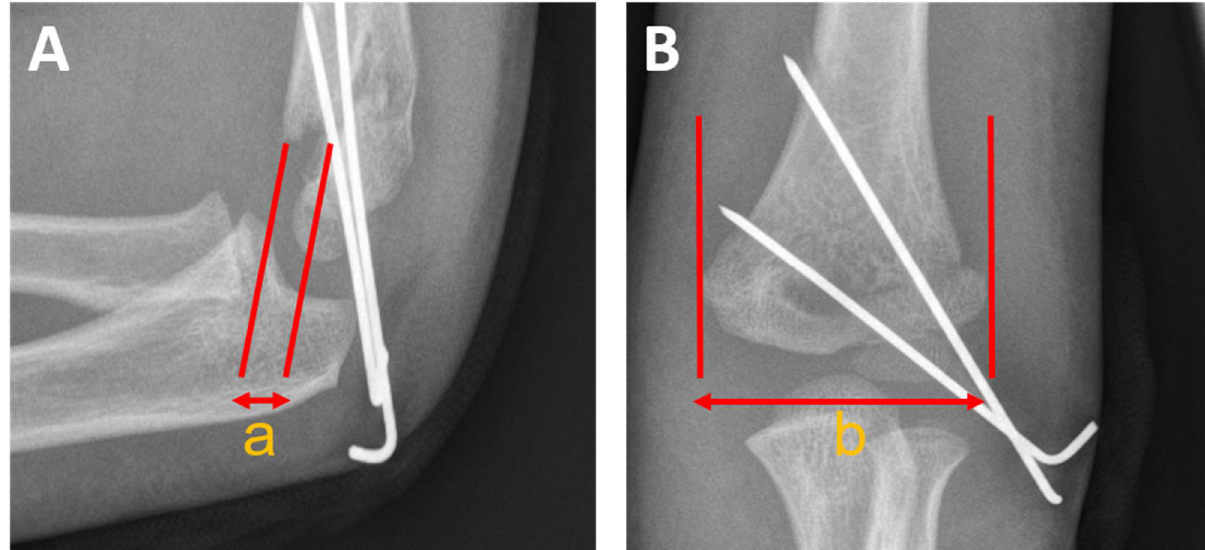
Figure 4. Calculation of the von Laer malrotation quotient (rfq). ( A ): Dimension of the rotational spur in millimeters ‘a’. ( B ): Dimension of the distal fragment ‘b’ in the anterior-posterior plane. For calculating the von Laer malrotation quotient (rfq), ‘a’ is divided by ‘b’ (a/b).